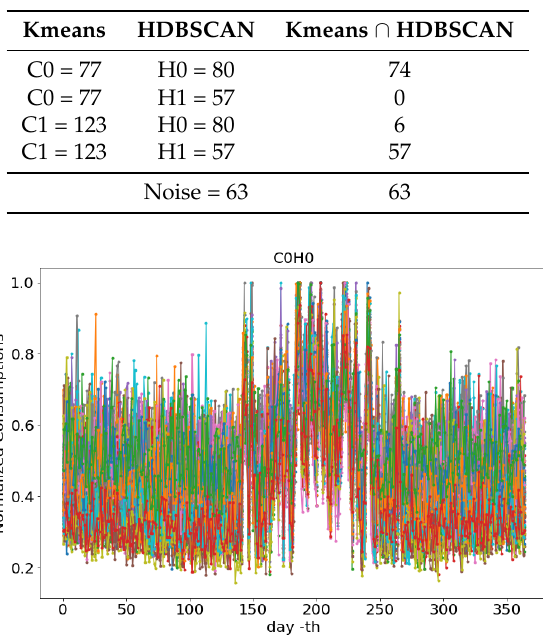
Table 9. Kmeans*HDBSCAN Candidate Cluster Determination.